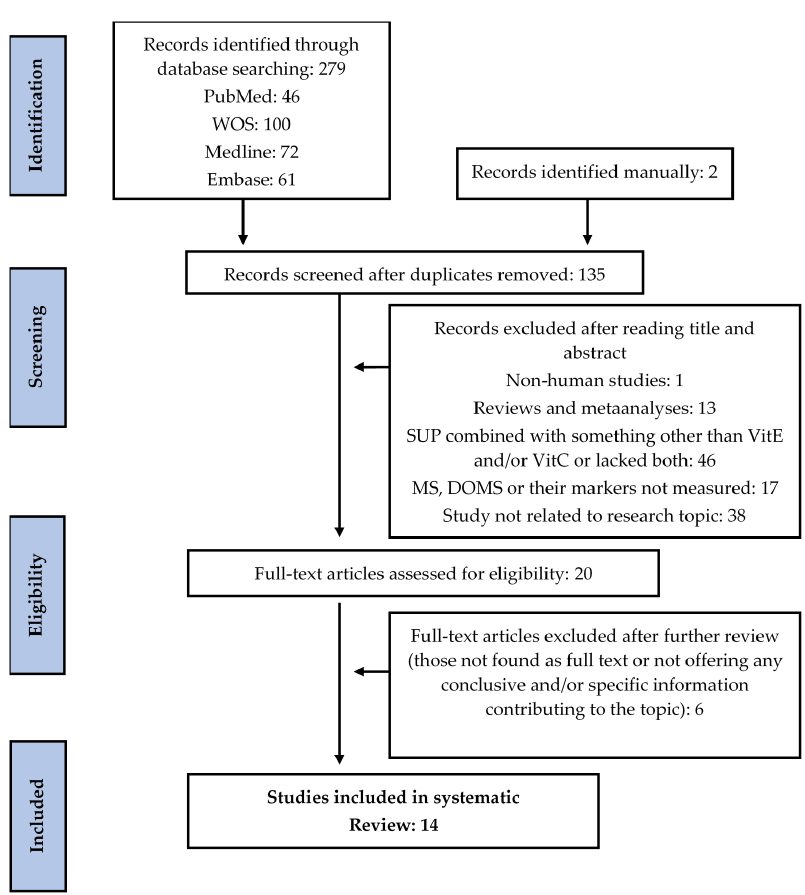
Figure 1. Flow diagram of literature search according to the Preferred Reporting Items for Systematic Reviews and Meta-Analyses (PRISMA) statement. SUP: supplementation; MS: muscle soreness; DOMS: delayed-onset muscle soreness; VitC: vitamin C; VitE: vitamin E; WOS: Web of Science.